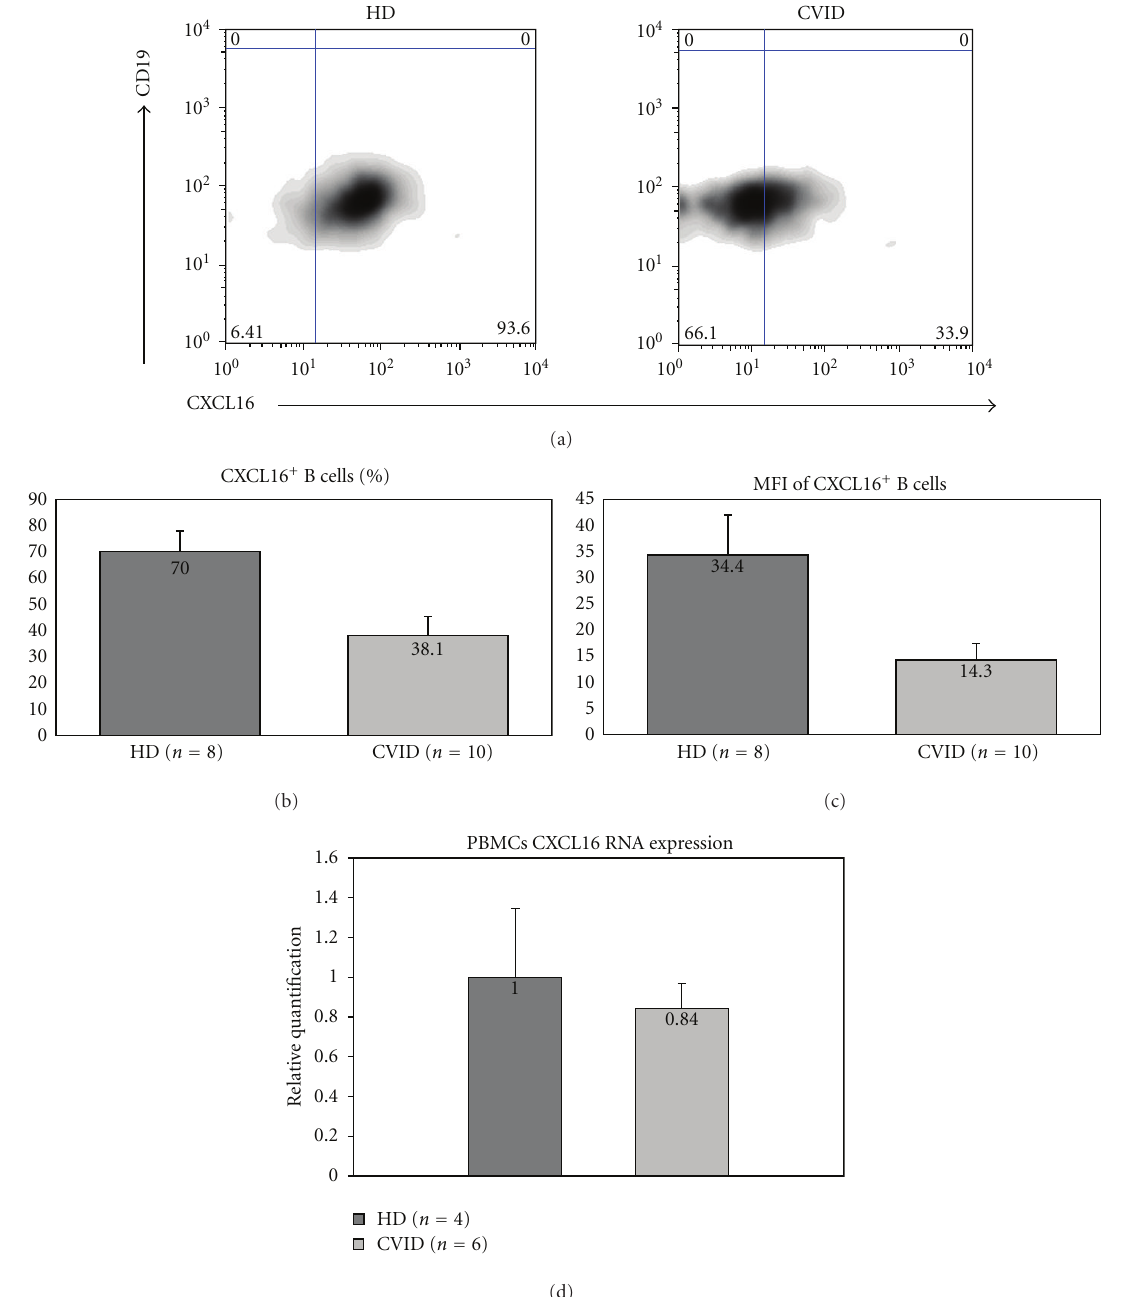
Figure 2: CXCL16 expression in CVID. (a) Reduced expression of CXCL16 on CVID B cells (representative experiment). (b) Mean of CXCL16 + B cells in healthy controls (number = 8) and CVID patients (number = 10). (c) Mean fluorescence intensity of CXCL16 on CD19 + B cells in cells in healthy controls (number = 10) and CVID patients (number = 10) (values expressed in mean). Graph bars show standard error (SE). (d) mRNA levels of CXCL16 from healthy controls and CVID patients.